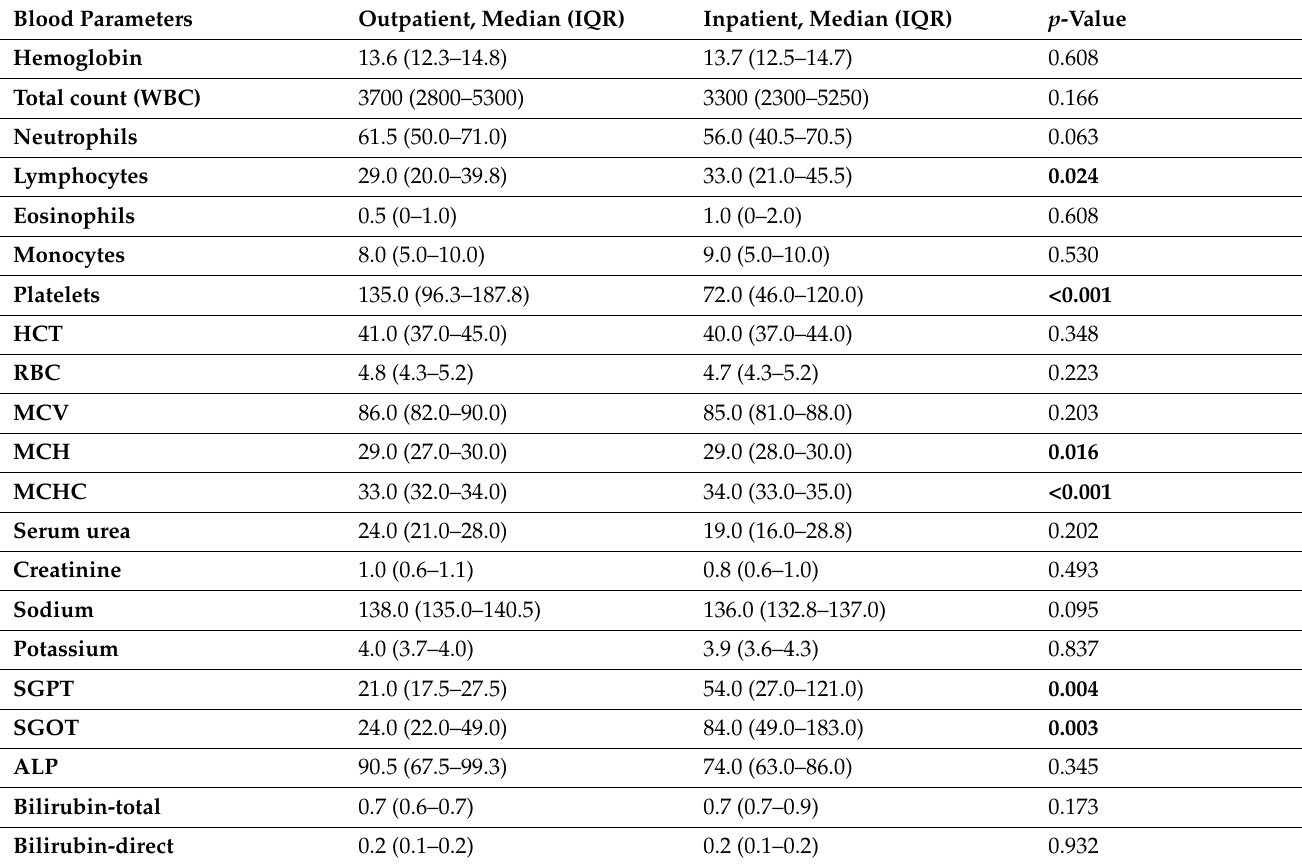
Table 2. Blood parameter profiles of dengue patients, Nepal,